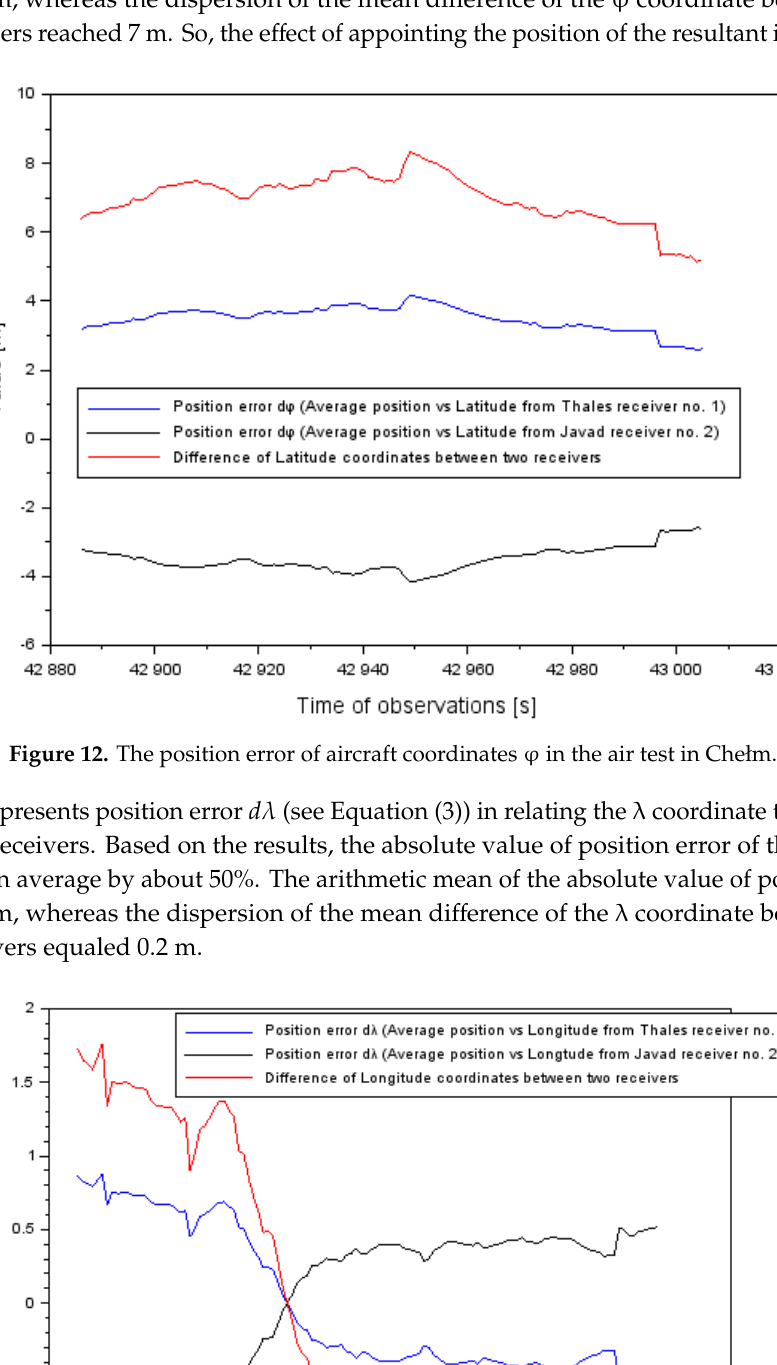
Figure 13. The position error of aircraft coordinates λ in the flight test in Che ł m.